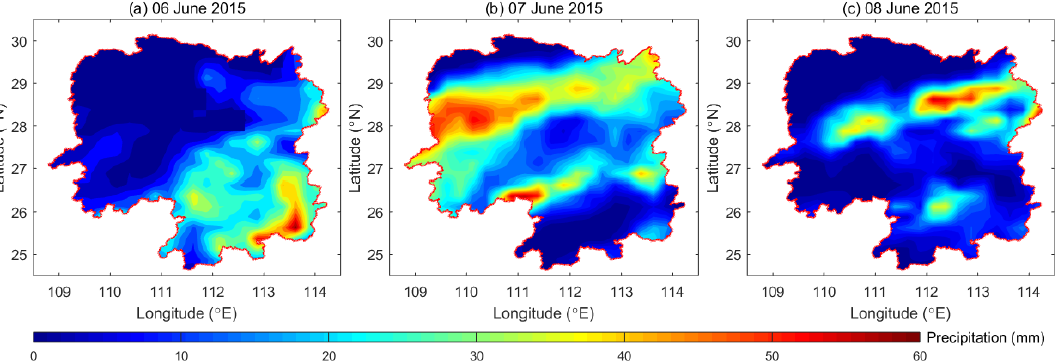
Figure 8. Map of daily accumulated precipitation in the Hunan Province on (a) 6 June 2015, (b) 7 June 2015 and (c) 8 June 2015. The precipitation data were retrieved from the TRMM with a spatial resolution of 0 . 25 ◦ × 0 . 25 ◦ .